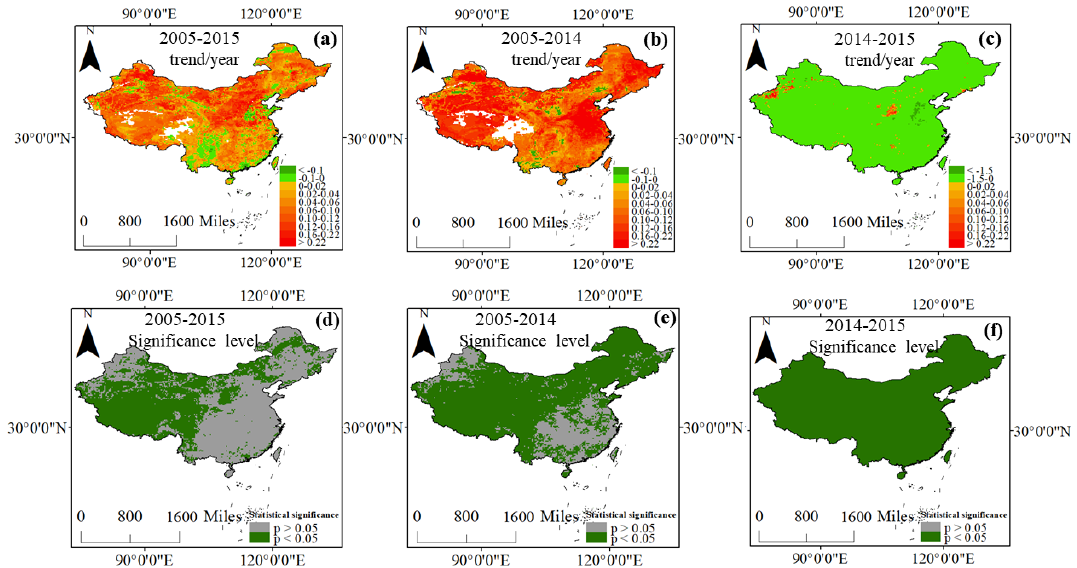
− concentrations (µgNm − 3 ) and significance levels in China ( a , b , and c denote the annual variation in Figure 8. The long-term trends of NO 3 ambient NO − concentration during 2005–2015, 2005–2014, and 2014/15, respectively. Panels (d) , (e) , and (f) represent the significance level 3 of the NO − trend during these periods). The pale green colour denotes the regions with significant variation in ambient NO − 3 ( p < 0 . 05), while the grey colour represents the regions with insignificant variation in NO − − concentrations in China, BTH, YRD, and PRD regions during 2005–2015. Table 4. The trend analysis of NO 3 Period Trend China BTH YRD PRD 2005–2014 Trend (µgNm − 3 yr − 1 ) 0.08